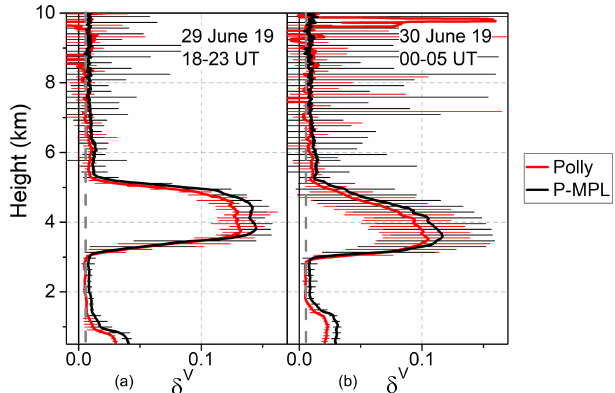
Figure 3. OVP-corrected (black thick lines) P-MPL RCS profiles using the F av function and the uncorrected RCS profiles (black OVP thin lines) with respect to (a) Polly (red line) and (b) MARTHA (blue line) RCS profiles, together with the OVP-corrected profiles using F original (cyan lines). OVP